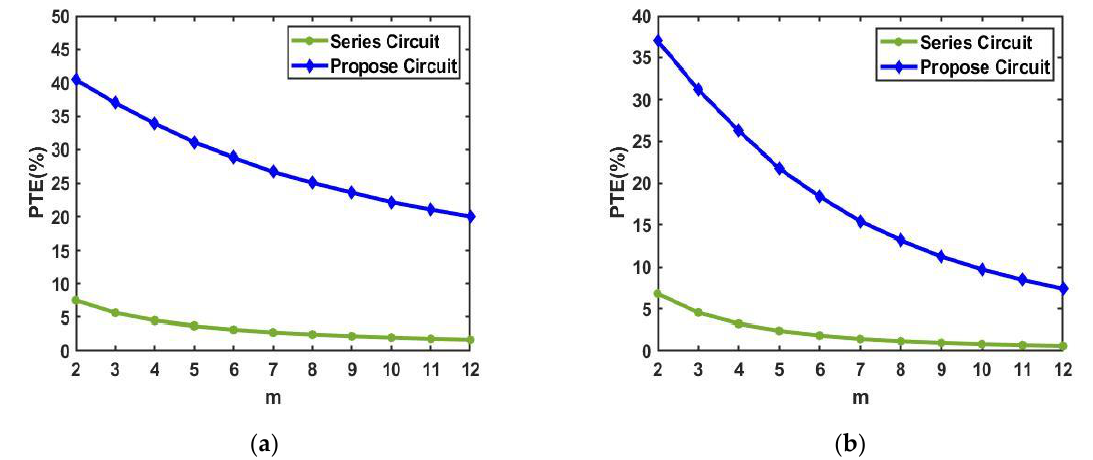
Figure 11. ( a ) PTE of the series circuit and the proposed circuit when n = m and ( b ) When n = 1.